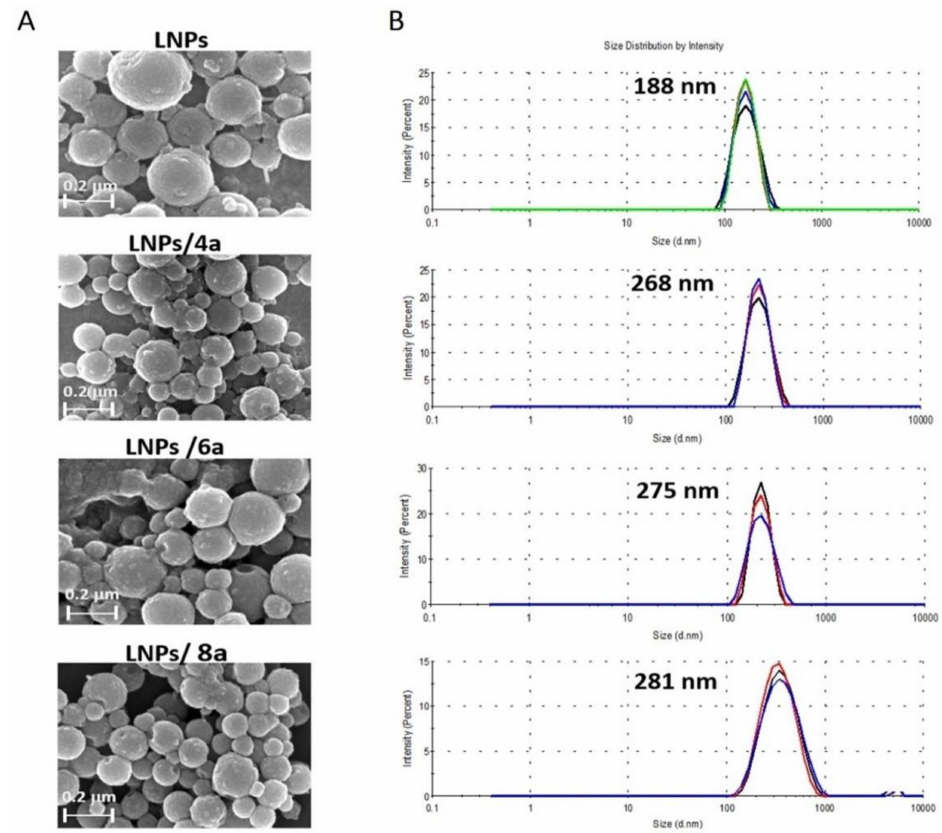
Figure 2. Morphological analysis of loaded and unloaded nanoparticles. Panel ( A ): Scanning electron microscopy of empty LNPs, and loaded LNPs/ 4a , LNPs/ 6a , and LNPs/ 8a . Panel ( B ): Dynamic light scattering analysis.